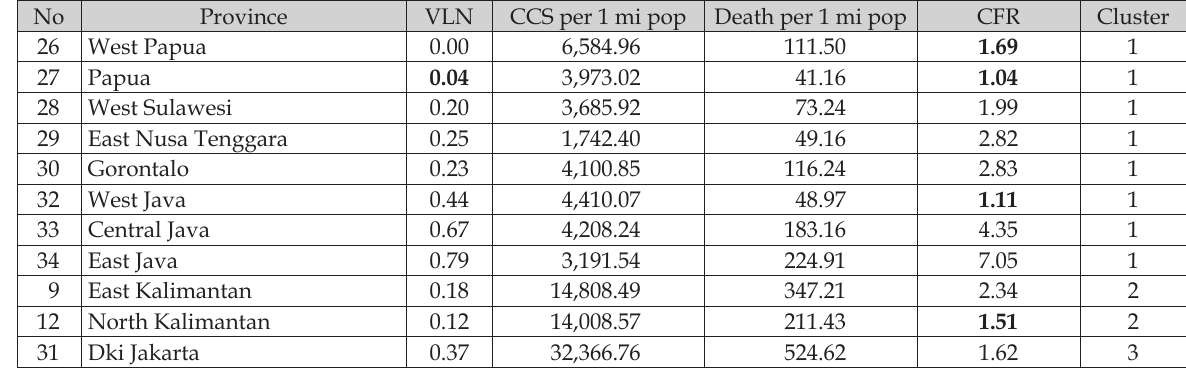
Table 3. Final cluster centre.